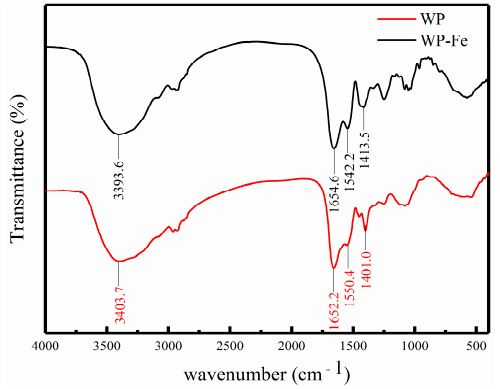
Figure 1. FTIR spectra of the WP and WP-Fe